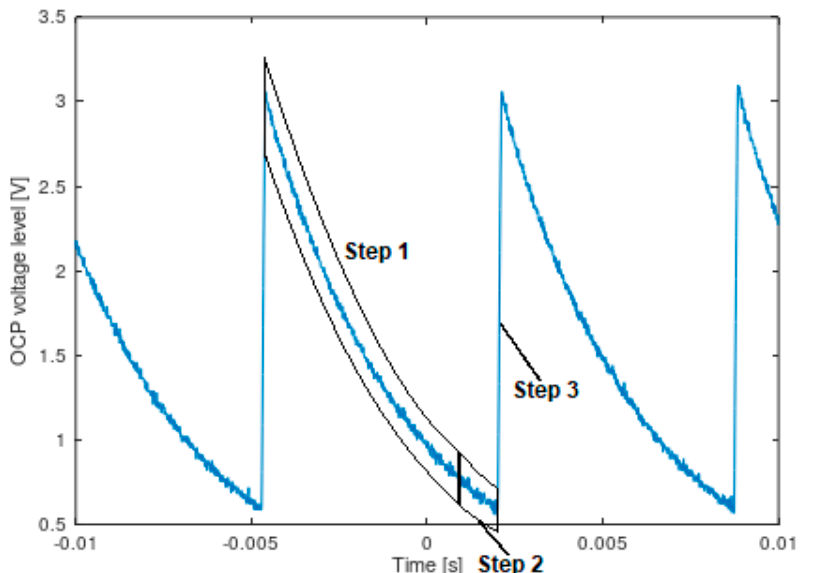
Figure 6. OCP signal as observed after the failure of the SUT010. 3 different phases/steps of operation of the PoL during failure are marked: (1) PoL is in the reset state and the OCP signal decreases; (2) OCP signal enters the range of logic low state and the PoL starts to operate; (3) OCP signal is triggered and the PoL is reset again.